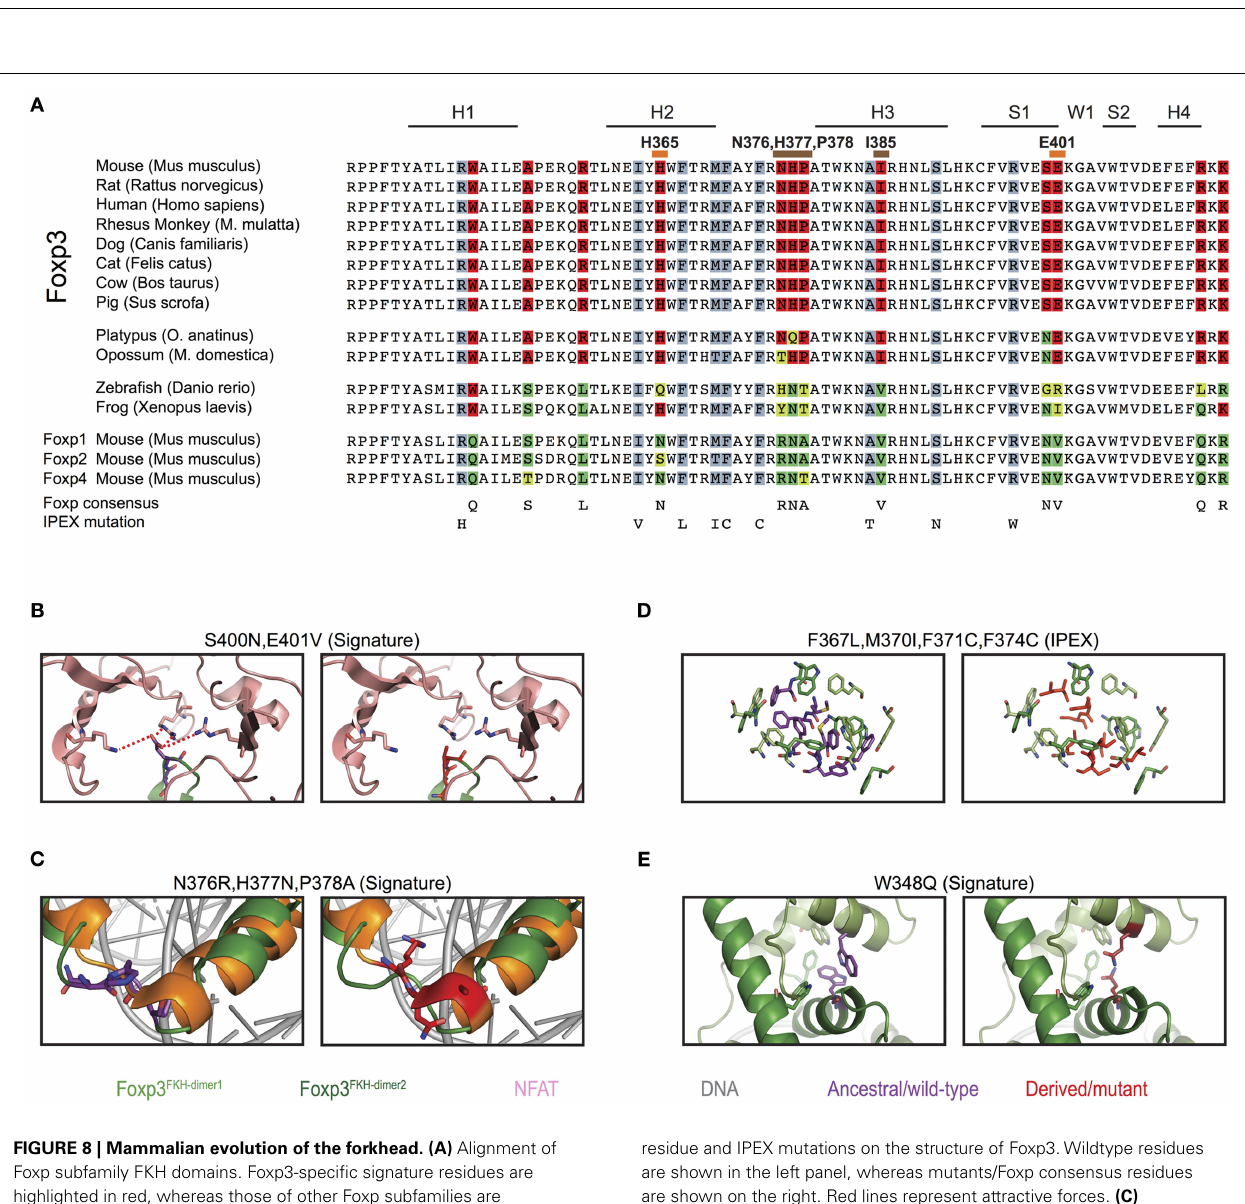
residue and IPEX mutations on the structure of Foxp3.Wildtype residues are shown in the left panel, whereas mutants/Foxp consensus residues are shown on the right. Red lines represent attractive forces. (C) Structure alignment of helix 2 and 3 of the FKH of Foxp3 (green; Bandukwala et al., 2011) and Foxp2 (orange; Stroud et al., 2006) with the Foxp3-specific (left panel; purple) and Foxp2 (right panel; red) residues